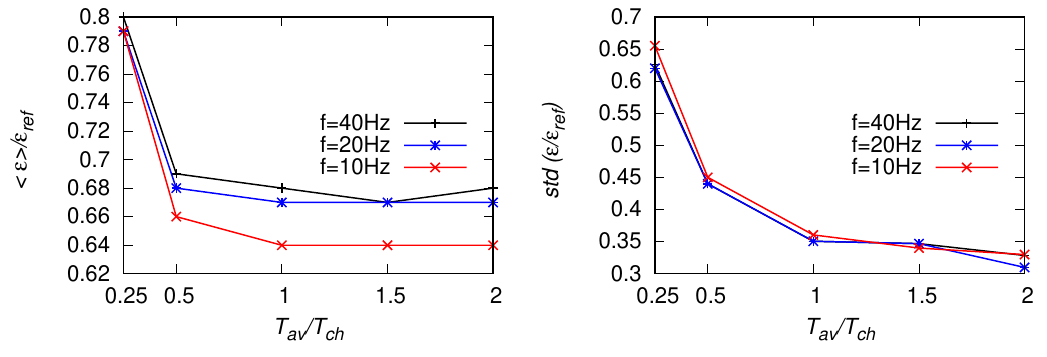
Figure 23. As in Figure 22 but for the fitting range f = [ 0.2 ÷ 5 ] Hz.